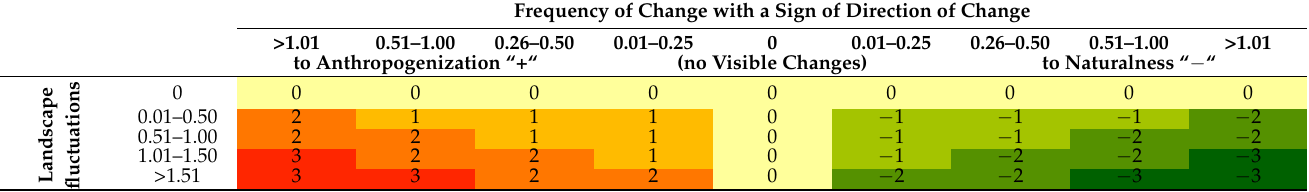
Table 2. Landscape anthropogenic instability matrix.